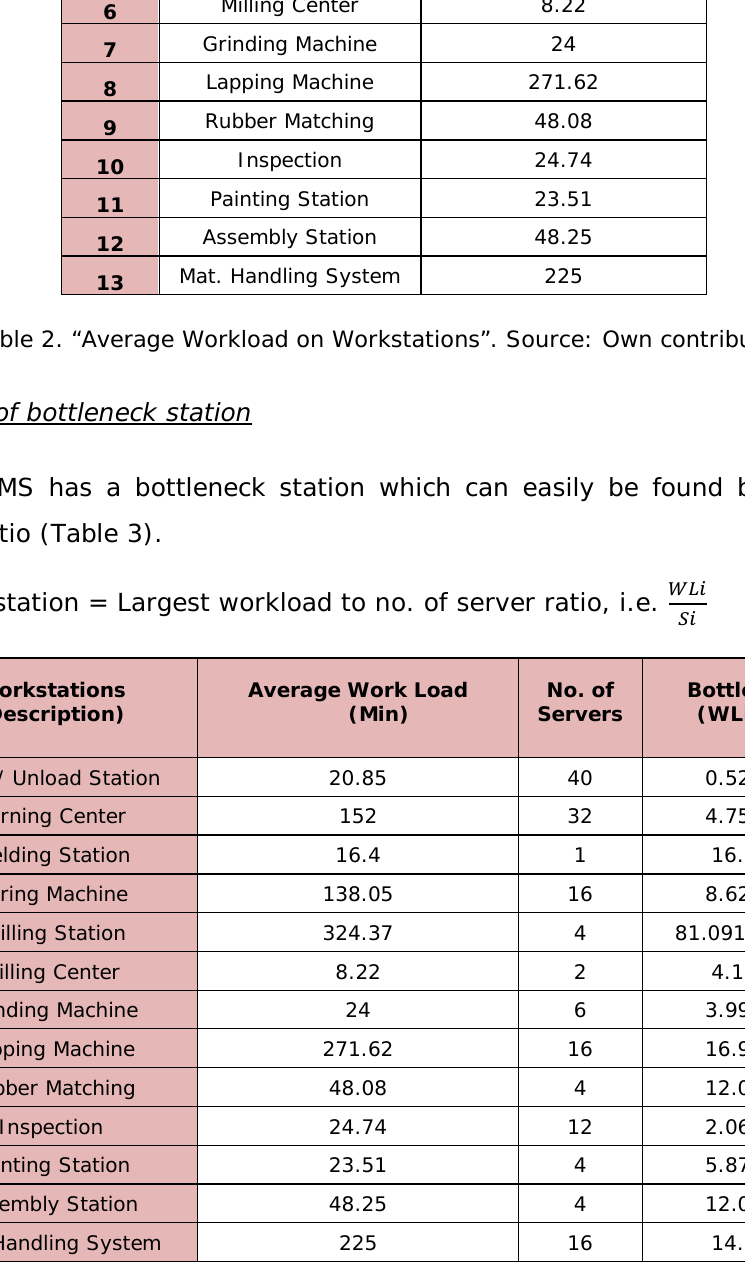
Table 3. “Estimation of Bottleneck Station”. Source: Own